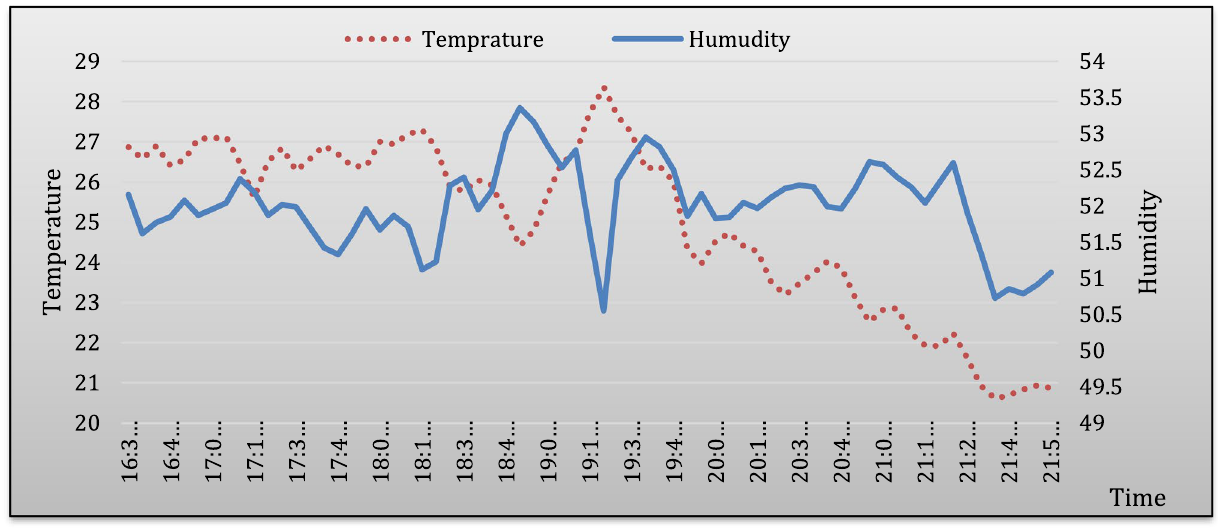
Fig. 7 Results of the experiment carried out on